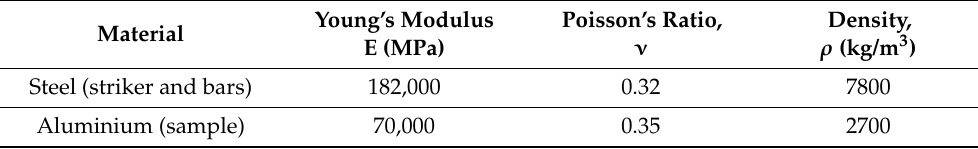
Table 3. Elastic properties of the bars and aluminium